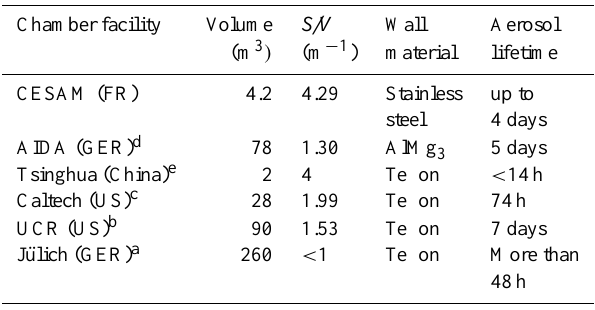
Table 9. Comparison of aerosol lifetime in different aerosol cham- ber